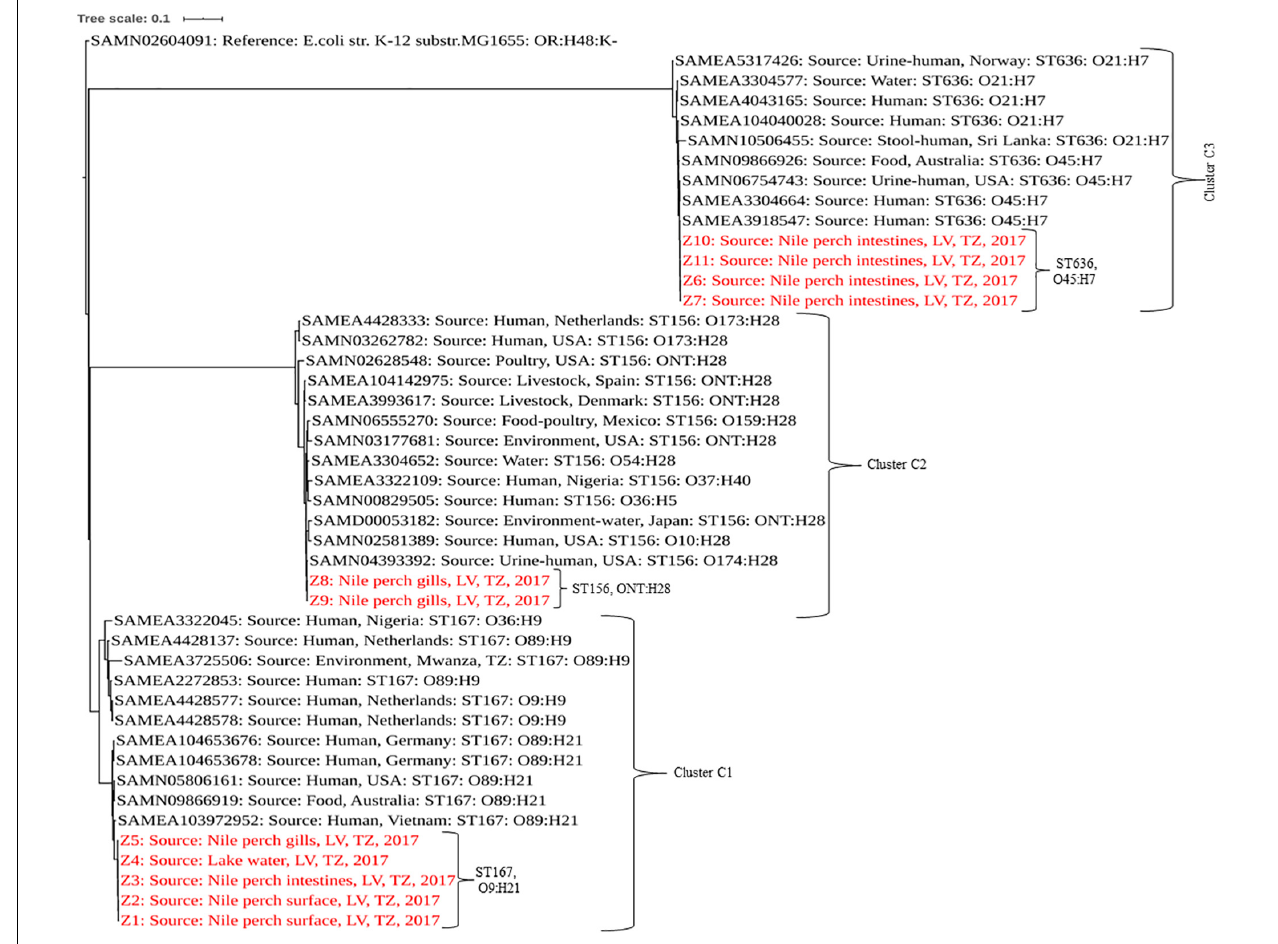
FIGURE 1 | Phylogenetic tree based on SNPs showing clonal relationship among ESBL-producing E. coli isolated from Nile perch and global public genomes of E. coli strains. Our strains are highlighted in red color. LV, Lake Victoria; TZ,